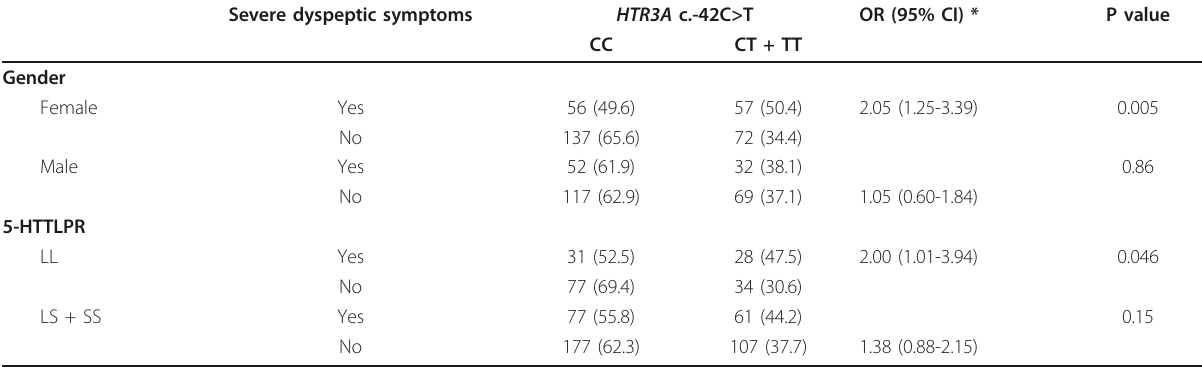
Table 4 Association between severe dyspeptic symptoms and HTR3A c.-42C > T genotype stratified by gender and 5-HTTLPR